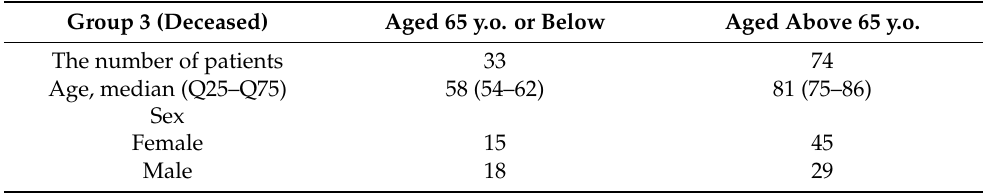
Table 20. Demographic data in Group 3 patients with